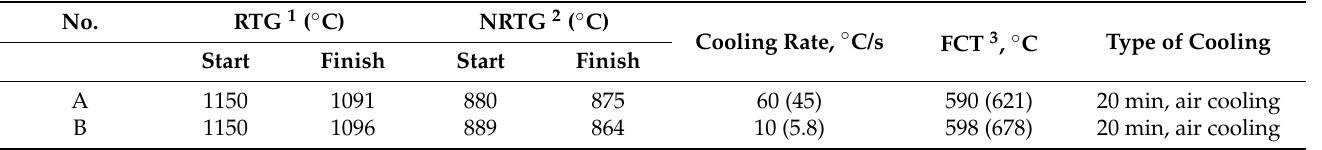
Table 2. Thermal mechanical processing parameters of the tested steels.